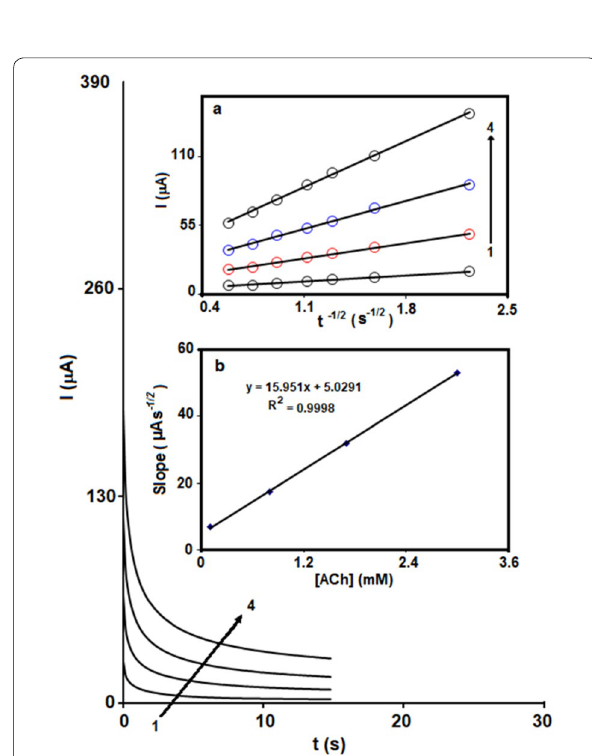
Fig. 4 Chronoamperograms obtained at MCSNP/SPE in 0.1 M PBS (pH 7.0) for different concentration of ACh. The numbers 1–4 correspond to 0.1, 0.8, 1.7 and 3.0 mM of ACh. Insets: Plots of I vs. t − 1/2 obtained from chronoamperograms 1–4 ( a ), and plot of the slope of the straight lines against ACh concentration ( b )